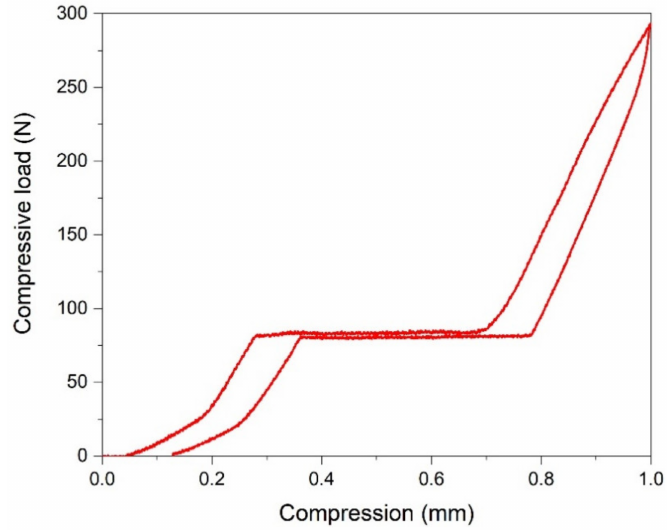
Figure 4. The shape memory response of Fe-Mn-Si-Cr SMA modules manufactured by HSHPT obtained during the compression loading/unloading